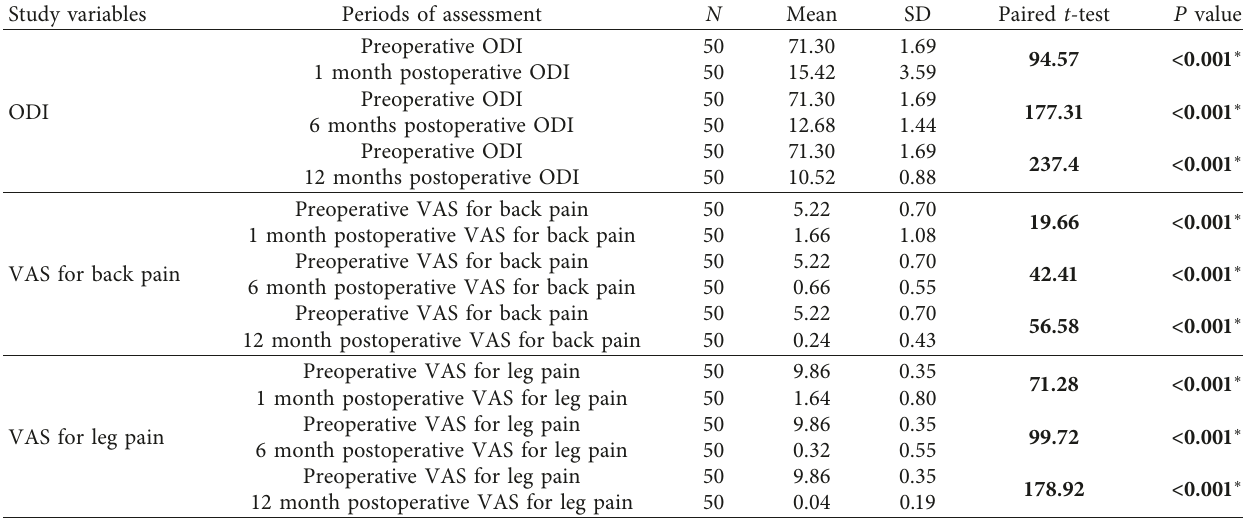
Table 4: The mean differences of ODI, VAS for back pain, and VAS for leg pain between preoperative and postoperative assessments three times.